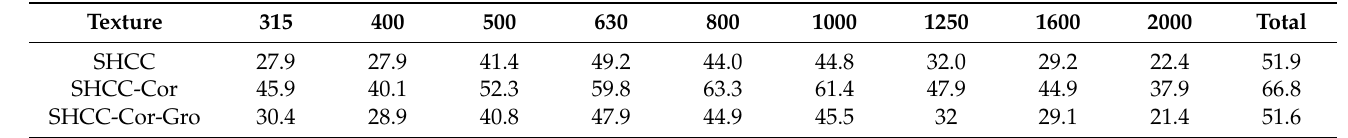
Table 6. Sound level (vibration) for SHCC, modified SHCC-Cor, and SHCC-Cor-Gro.